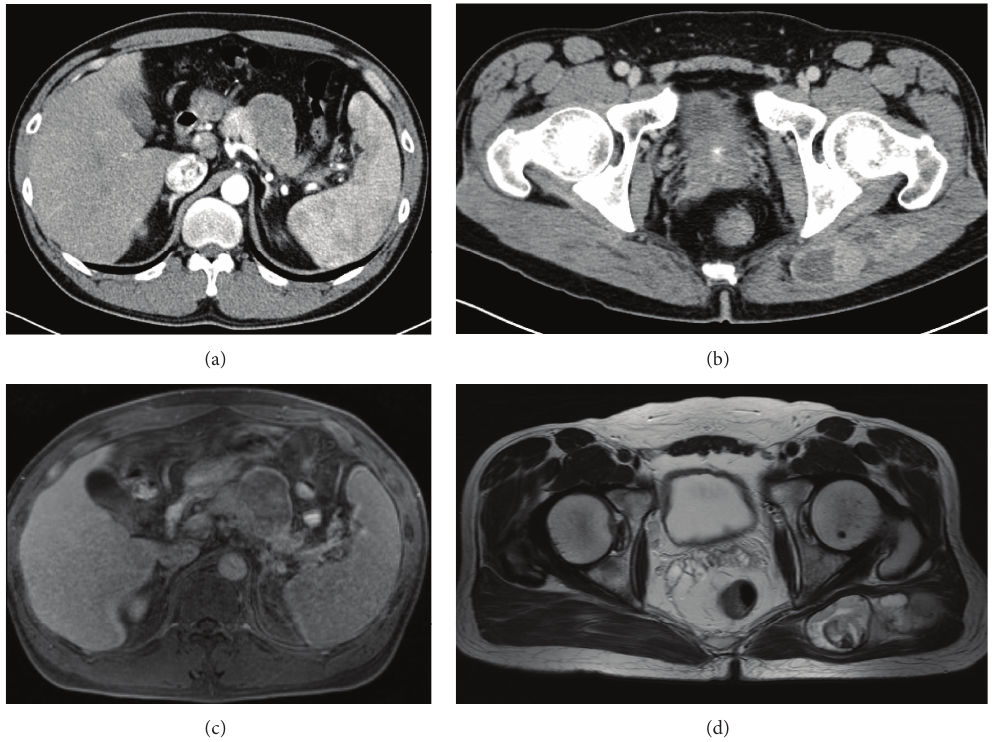
Figure 1: (a) Abdominal computed tomography, showing a well-circumscribed, low-attenuation, inhomogeneously enhancing mass mea- suring about 5cm in diameter in the body and tail of the pancreas. (b) Abdominal computed tomography, showing a well-circumscribed, heterogeneously enhancing mass measuring about 8 cm × 3 cm in the left buttock. (c) Abdominal magnetic resonance imaging, showing a well-circumscribed mass measuring 4.5cm in diameter in the body and tail of the pancreas. The mass had inhomogeneous enhancement with gadolinium diethylenetriaminepentaacetic acid on T1-weighted fat-suppression images. (d) Magnetic resonance imaging of the lesion in the left buttock, showing an inhomogeneously hyperintense mass on T2-weighted